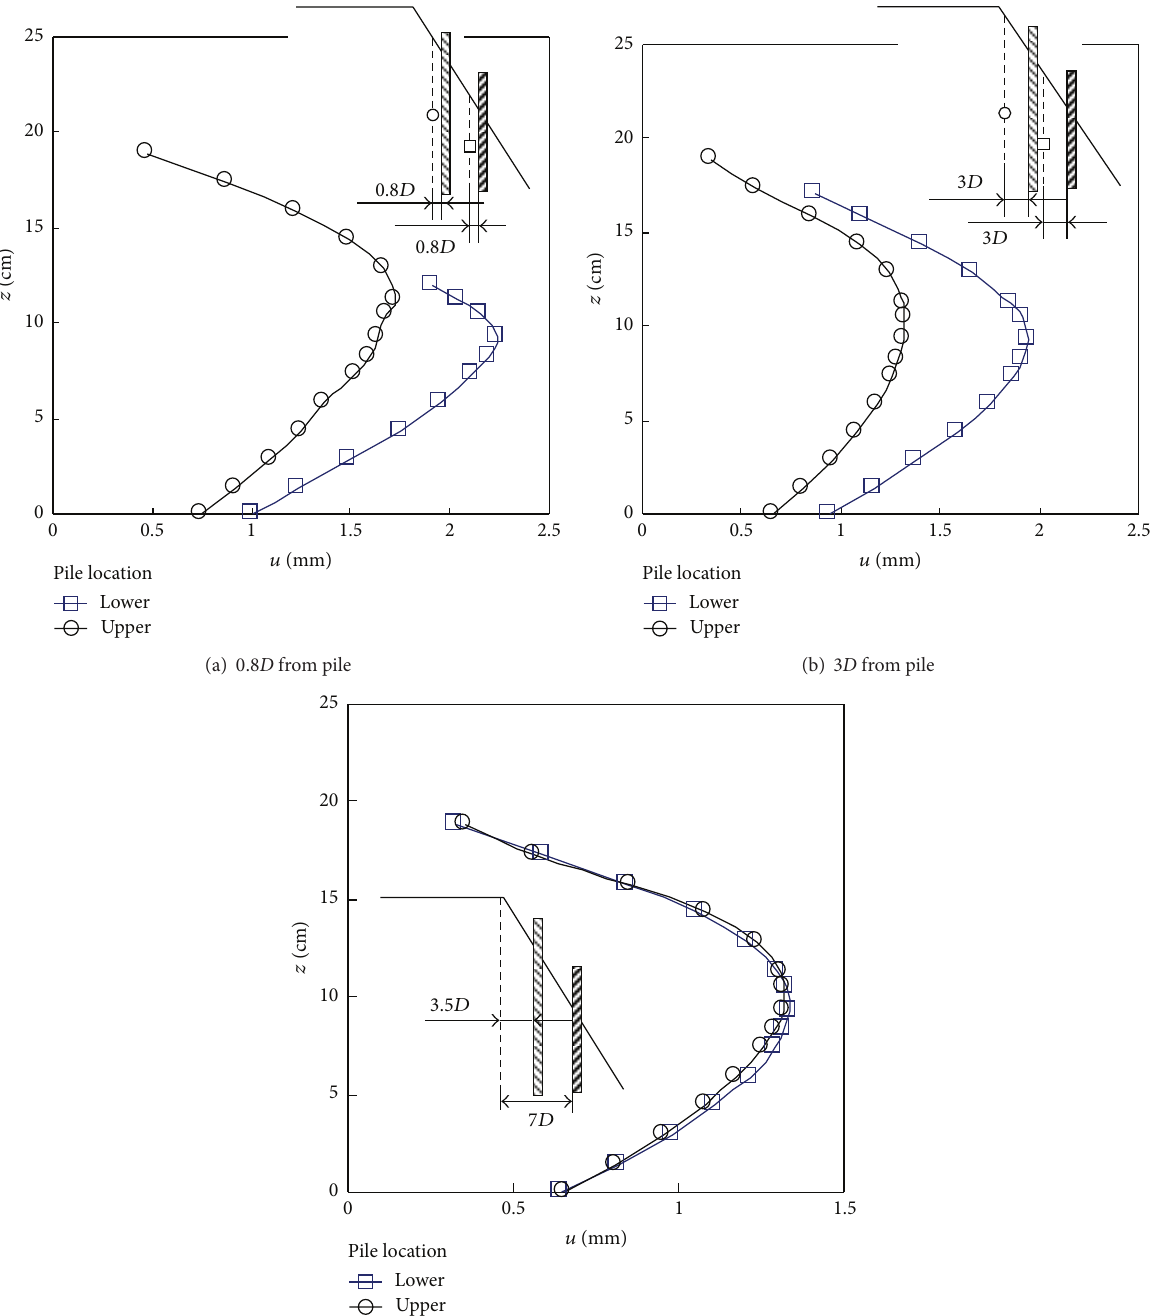
Figure 17: Influence of positions of the pile by numerical analysis. D : pile diameter; u : horizontal